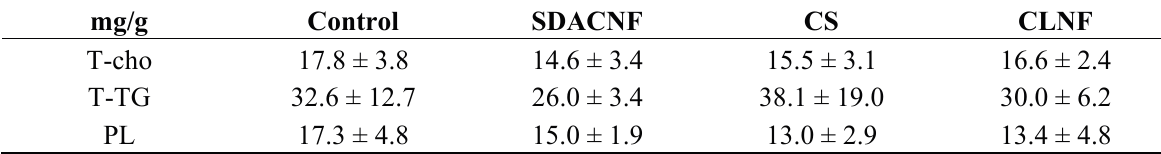
Table 5. Effects of oral administration of SDACNFs on the lipid content in the liver. The table indicates the results of lipid contents in the liver. Data present mean ± standard error.